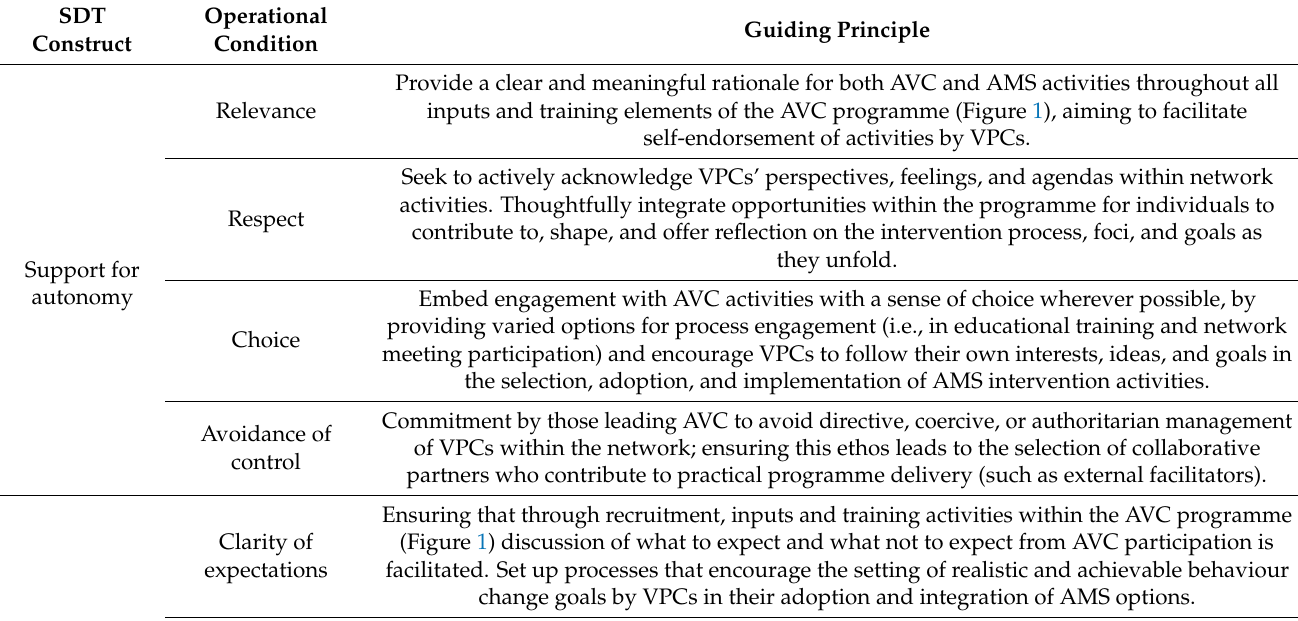
Table 1. Operational conditions of self-determination theory posited by Silva, Marques, and Teixera [27] for consideration in intervention design and their adaptation to guiding principles for appropriate enactment within Arwain Vet